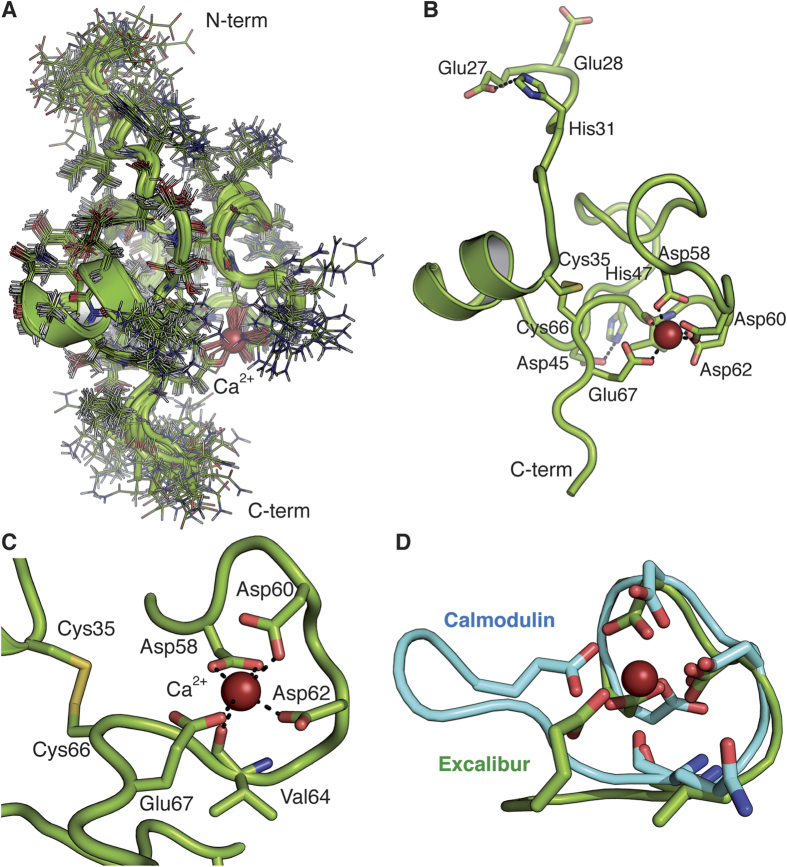
Structure of the Excalibur domain determined by NMR.(A) Superposition of the 20 low energy conformers of the Excalibur domain determined by NMR. Ca2+ is depicted in red sphere. (B) Ribbon representation of one Excalibur conformer showing its main structural features. (C) Ca2+-binding loop architecture and localization of the disulfide bridge. (D) Backbone superimposition between the Ca2+-binding loop of the Excalibur domain and calmodulin (PDB code 1CLL) with a rmsdbackbone = 0.69 Å.